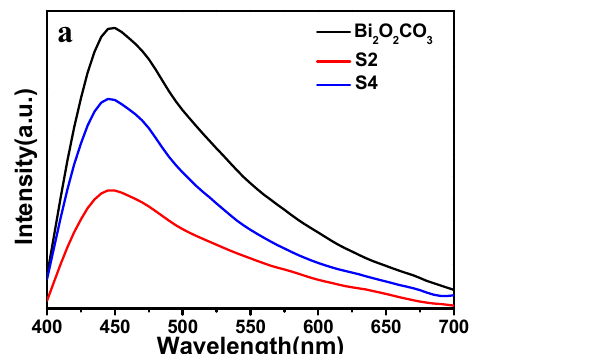
8 of 13 Figure 7. ( a ) The photo-degradation curves of Cr (VI) (30 mg/L) over S2 in the presence of different scavengers, ( b ) cycling times of the photocatalytic degradation of Cr(VI) (30 mg/L) under solar light irradiation, ( c ) the XRD pattern and ( d ) the SEM pattern of S2 after five repeated cycles. The room temperature PL emission spectra of the pure Bi 2 O 2 CO 3 , S2 and S4 (pure BiOI) are shown in Figure 8a. The PL emission intensity of S2 is the lowest one among the three samples, which implies 1D/2D heterostructure effectively suppresses the recombi-